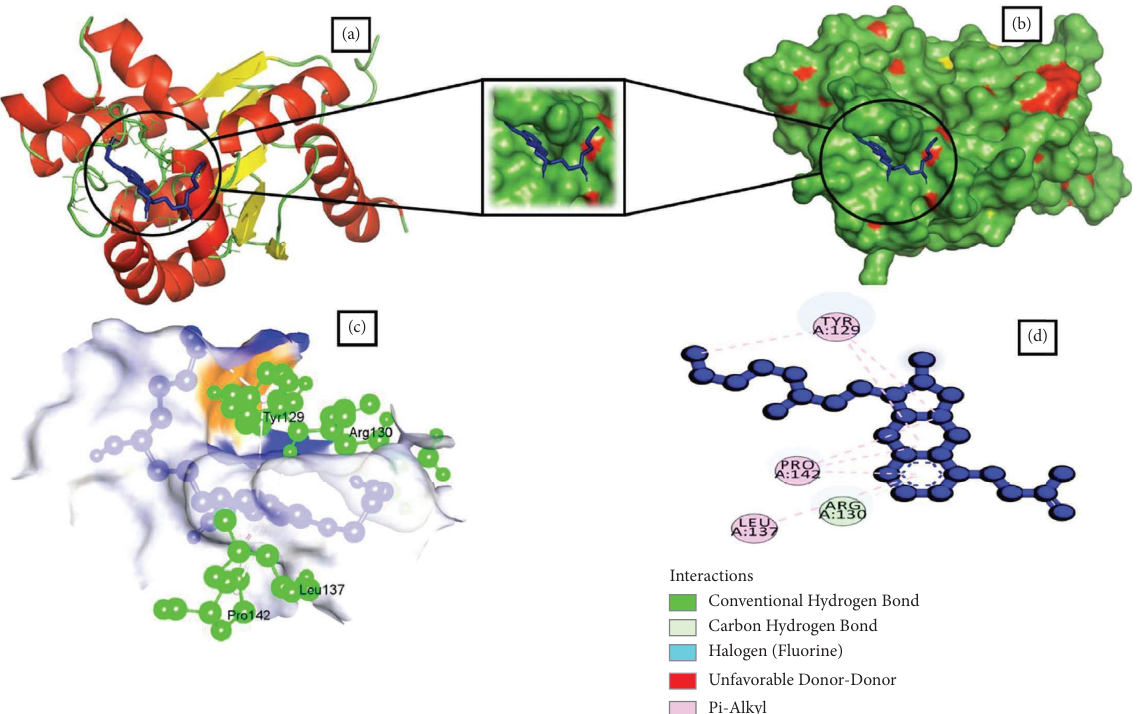
Figure 2: Schematic representation of Shikimate kinase_CHEMBL1237119 complex. (a) Pose view of Shikimate kinase_CHEMBL1237119 complex. (b) Surface view of Shikimate kinase_CHEMBL1237119 complex. Here, protein is in red, yellow, and green color and ligand is in blue color. (c, d) 3D and 2D interaction of Shikimate kinase_CHEMBL1237119 complex. Here, protein is in green color and ligand is in blue